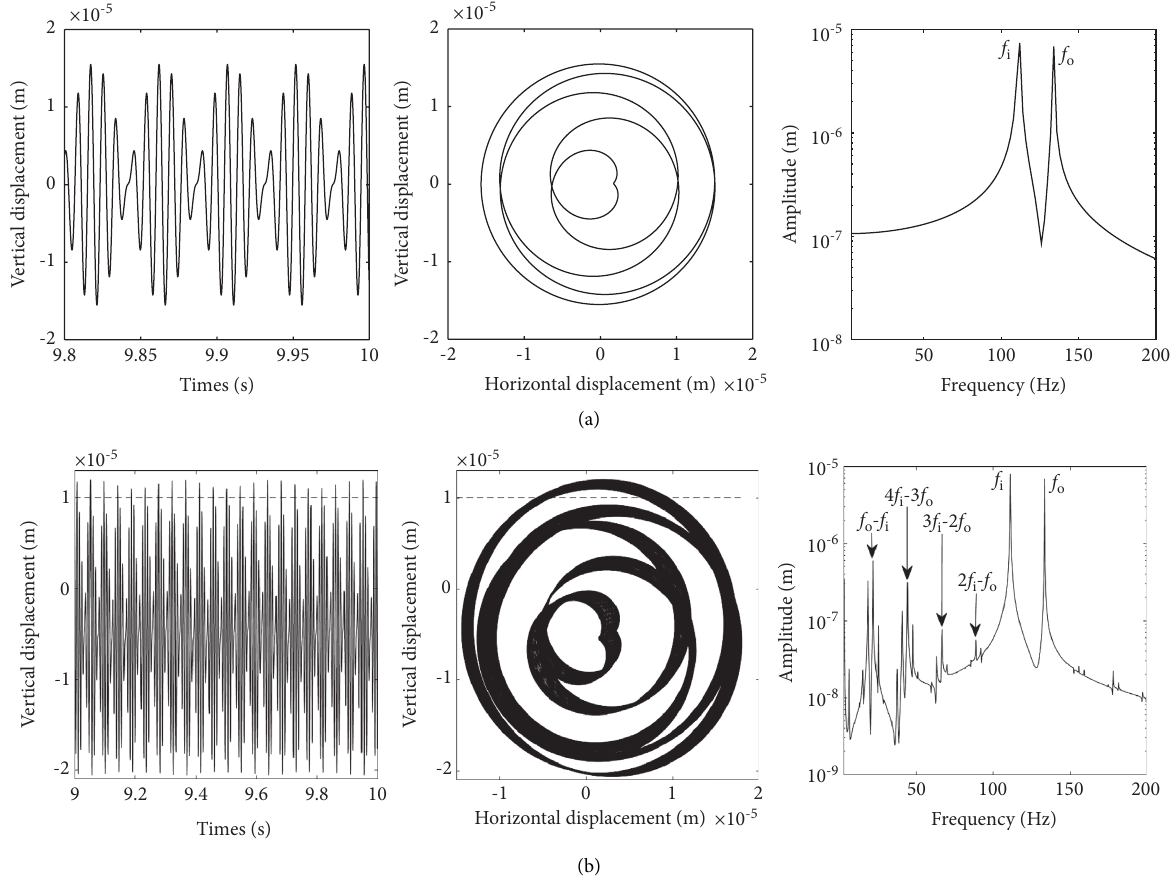
Figure 17: Dynamic responses of the outer rotor with K rotor response with rub-impact.